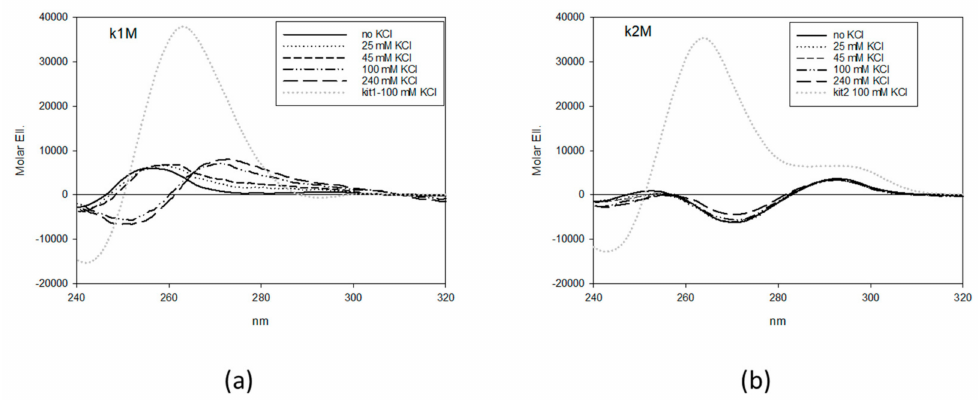
Figure 1. Circular dichroism titrations of 4 µ M k1M ( a ) and k2M ( b ) with increasing concentrations of KCl in 10 mM Tris, pH 7.5, 25 ◦ C. Grey dotted lines refer to the corresponding wild type sequences in 100 mM